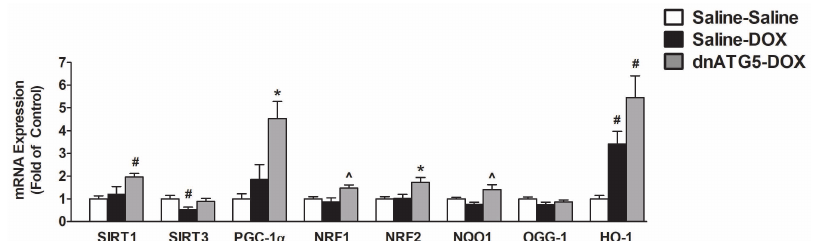
Figure 8. Markers of mitochondrial volume and the antioxidant response element signaling. mRNA expression of sirtuin 1 (SIRT1), sirtuin 3 (SIRT3), peroxisome proliferator-activated receptor gamma co-activator 1-alpha (PGC-1 α ), nuclear respiratory factor-1 (NRF1), nuclear factor erythroid-2-related factor-2 (NRF2), NAD(P)H quinone dehydrogenase-1 (NQO1), 8-oxoguanine DNA glycosylase (OGG-1), and heme oxygenase-1 (HO-1). Values are represented as means ± SEM. * significantly di ff erent versus all groups ( p < 0.05). # significantly di ff erent versus Saline-Saline ( p < 0.05). ˆ significantly di ff erent versus Saline-DOX ( p <